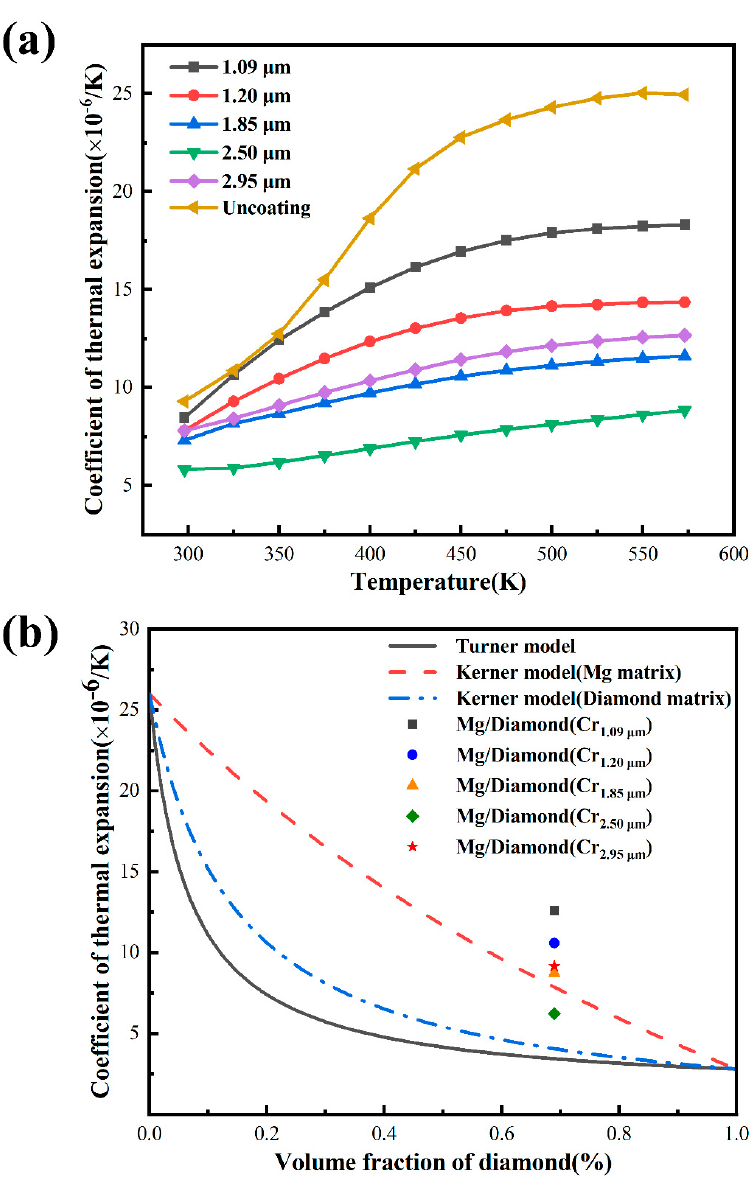
Figure 7. ( a ) Thermal expansion coefficient of Mg/diamond (Cr) composites; ( b ) theoretical calculation and experimental analysis results of thermal expansion coefficient of Mg/diamond (Cr) composites.